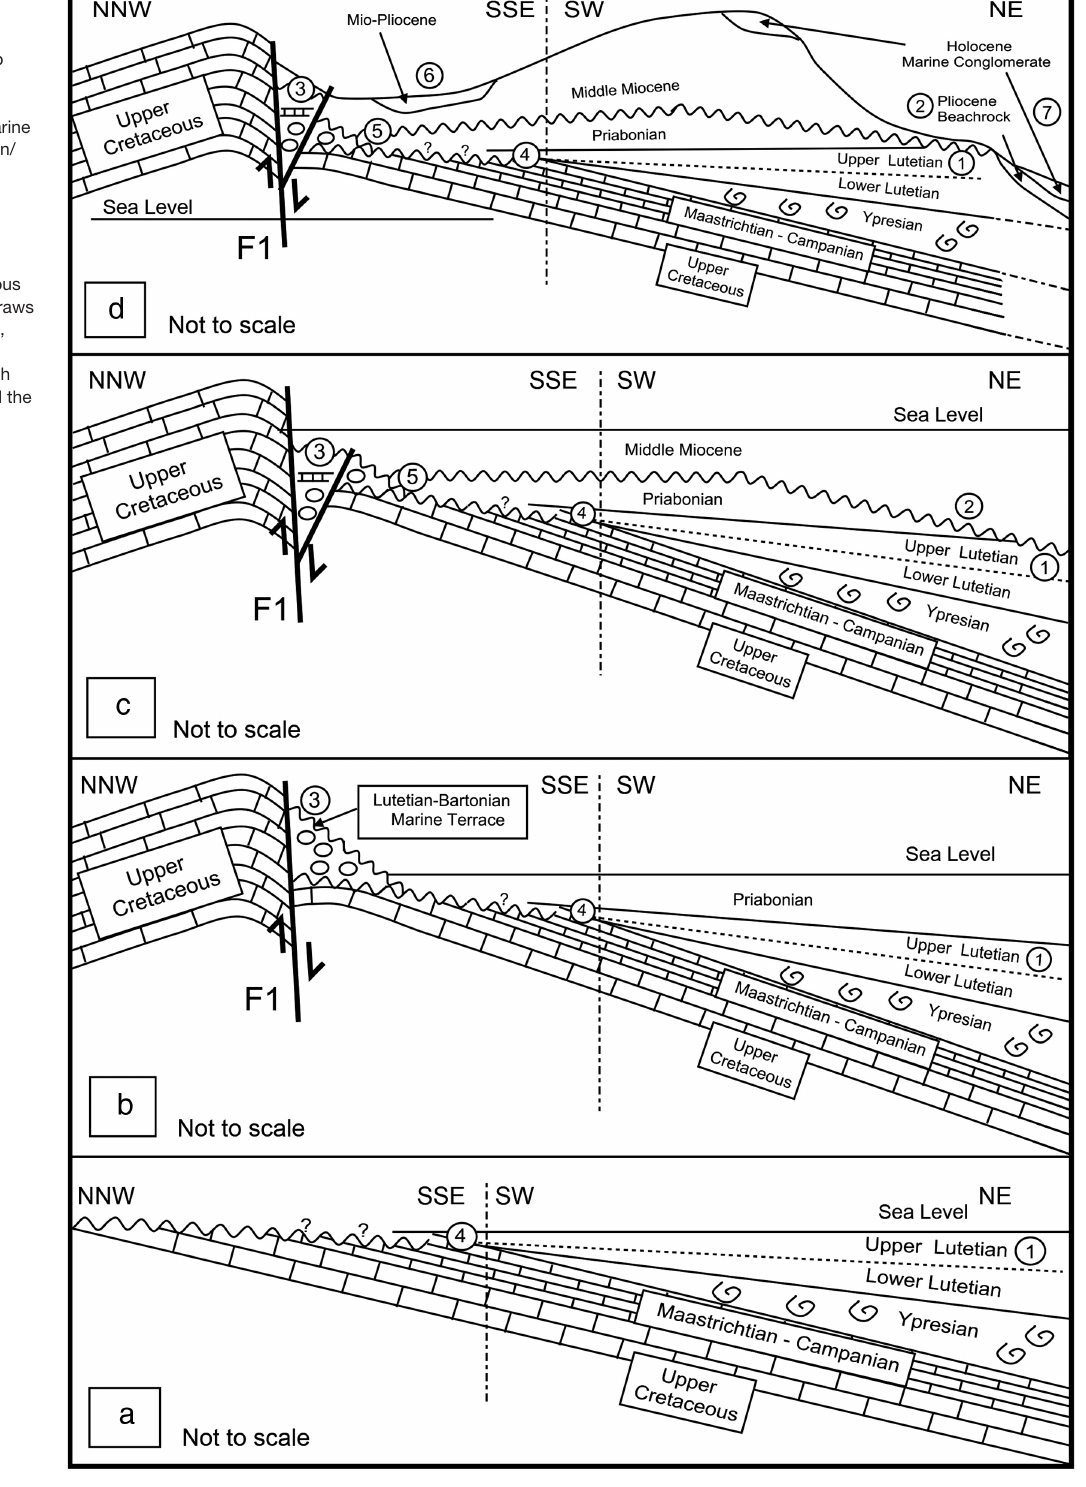
(a) Draws the Lutetian coastal onlap as far south of the harbour area by site 4; (b) marks the West Beirut displacement post-Lutetian and marine terrace formation during the Lutetian/ Bartonian time and the onset of the Priabonian coastal onlap recorded from site 2; (c) shows the renewed displacement of F1 fault preceding the middle Miocene coastal onlap and the Miocene/Eocene diachronous unconformity in sites 1 and 2; (d) draws remnant of a coastal onlap in site 6, the early Pliocene shoreline section of site 2, and the latest raised beach marine conglomerates of site 7 and the topmost “achrafieh”